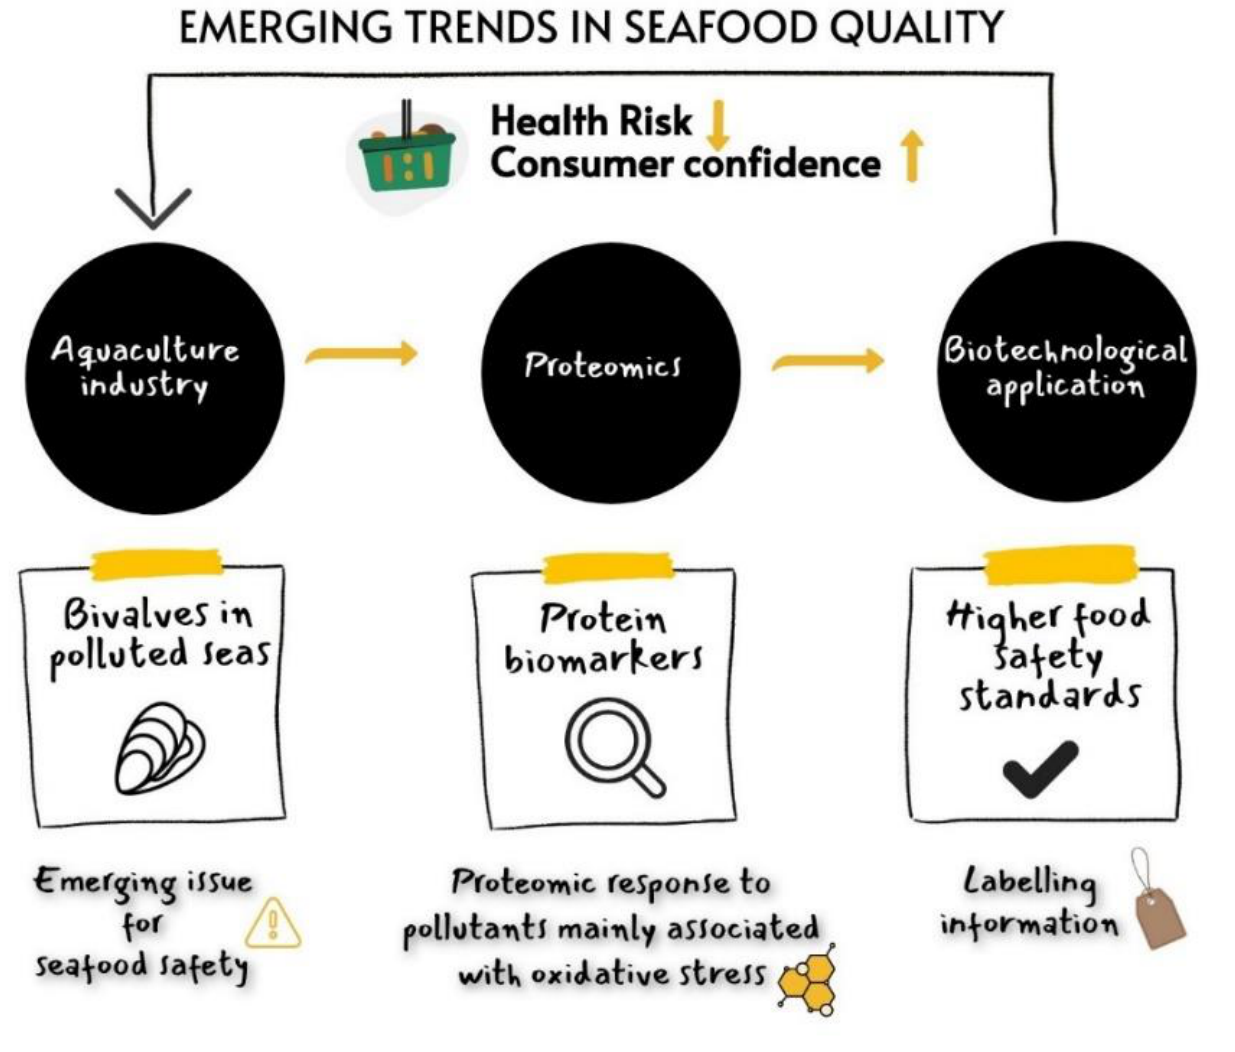
Figure 1. Emerging challenges in seafood quality.